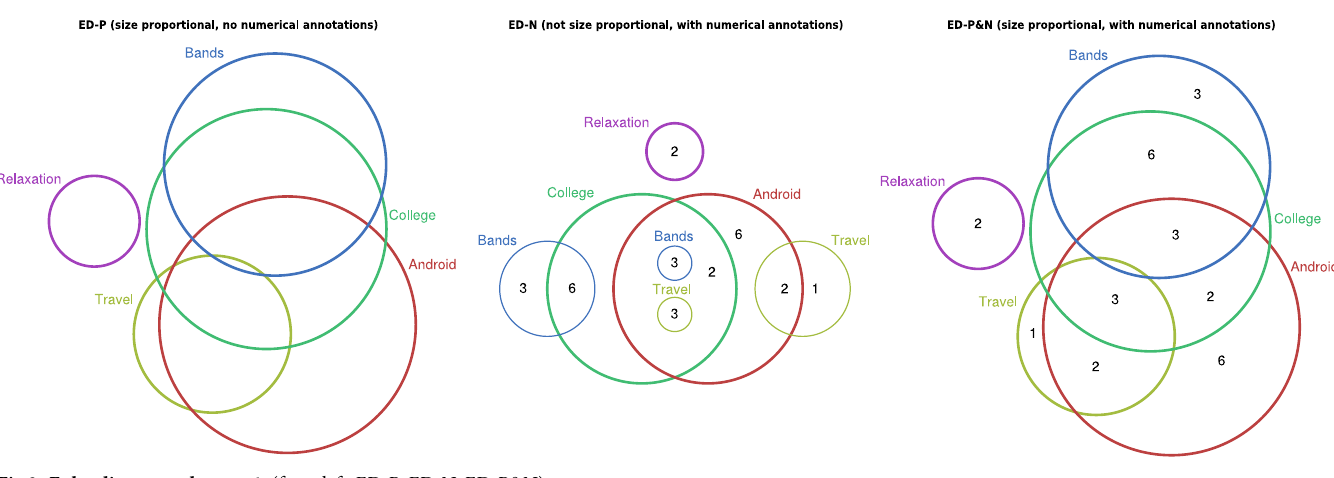
Fig 2. Euler diagrams, data set 1. (from left: ED-P, ED-N, ED-P&N).